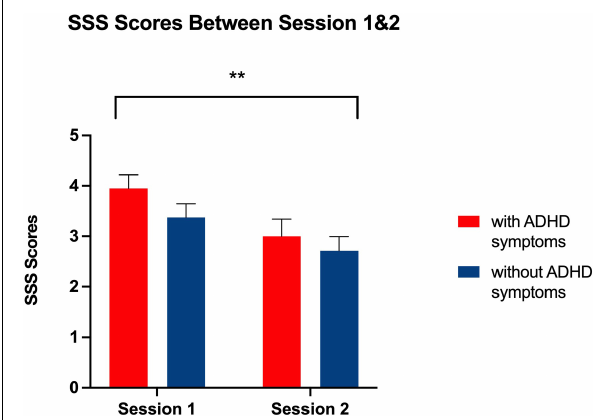
FIGURE 5 | Bar graph showing Stanford Sleepiness Scale Ratings at Session 1 and 2 for each group. **Indicates a significant main effect of session, p < 0.01, with higher ratings of self-reported sleepiness being reported at Session 1 than Session 2 related to all participants’ evening